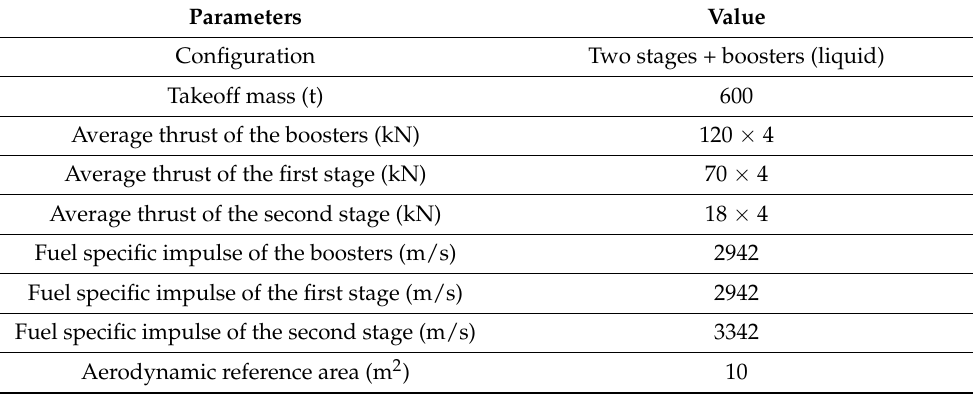
Table 1. General parameters of the launch vehicle.